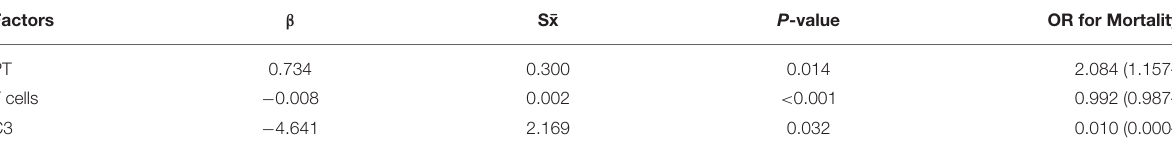
TABLE 4 | Logistic regression of independent prognostic factors for mortality ( r 2 = 0.741, P < 0.001). Factors β S¯x P -value